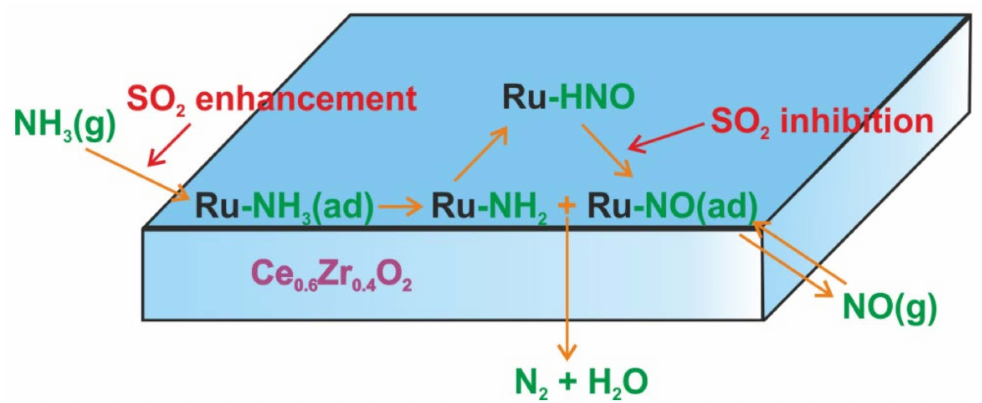
Figure 8. Mechanism of NH 3 -SCO and effect of SO 2 . Reprinted from [105] with permission of ACS